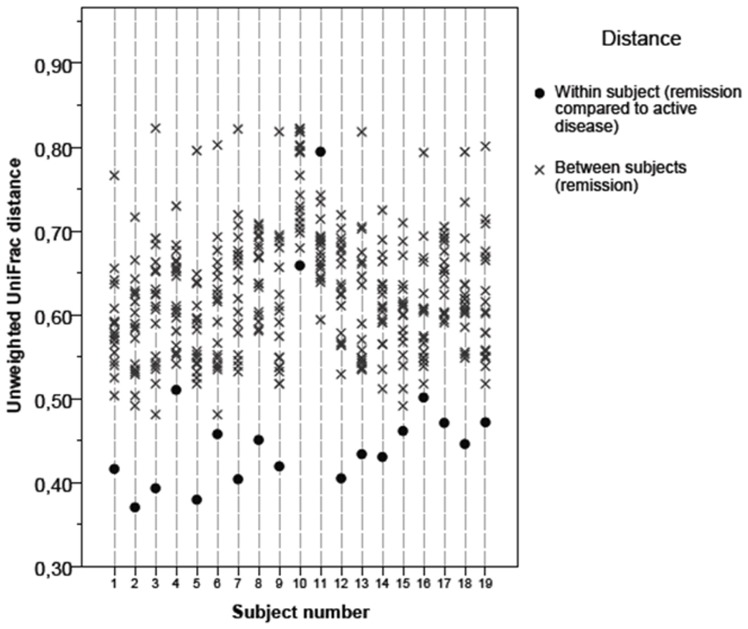
Within and between subjects pair-wise unweighted UniFrac distances for ulcerative colitis (#1–9) and Crohn’s disease (#10–19) patients.